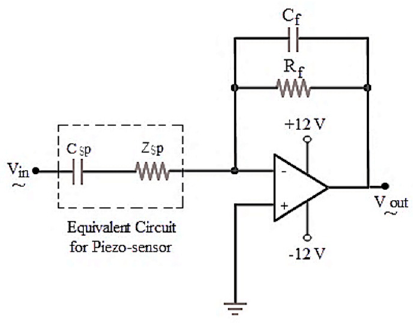
Figure A1. Current to voltage converter circuit for the piezoelectric films undergone the P-E hysteresis loop measurement [41].